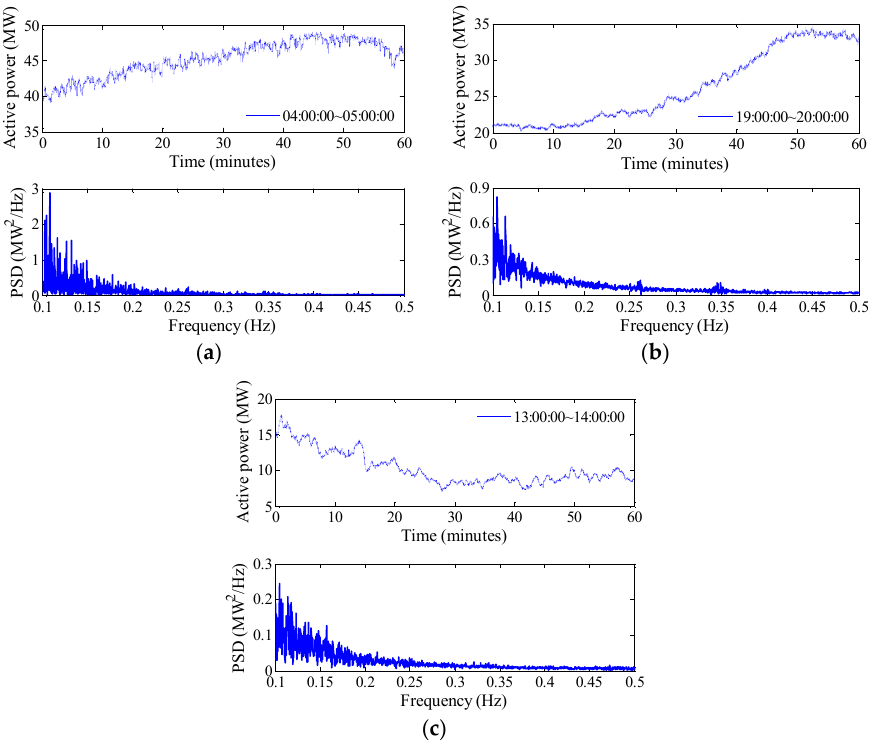
Figure 5. Time-domain curve and corresponding PSD of wind power fluctuation of one hour. ( a ) Properties of the output power during the peak period; ( b ) Properties of the output power during the trough period; ( c ) Properties of the output power during the medium period.